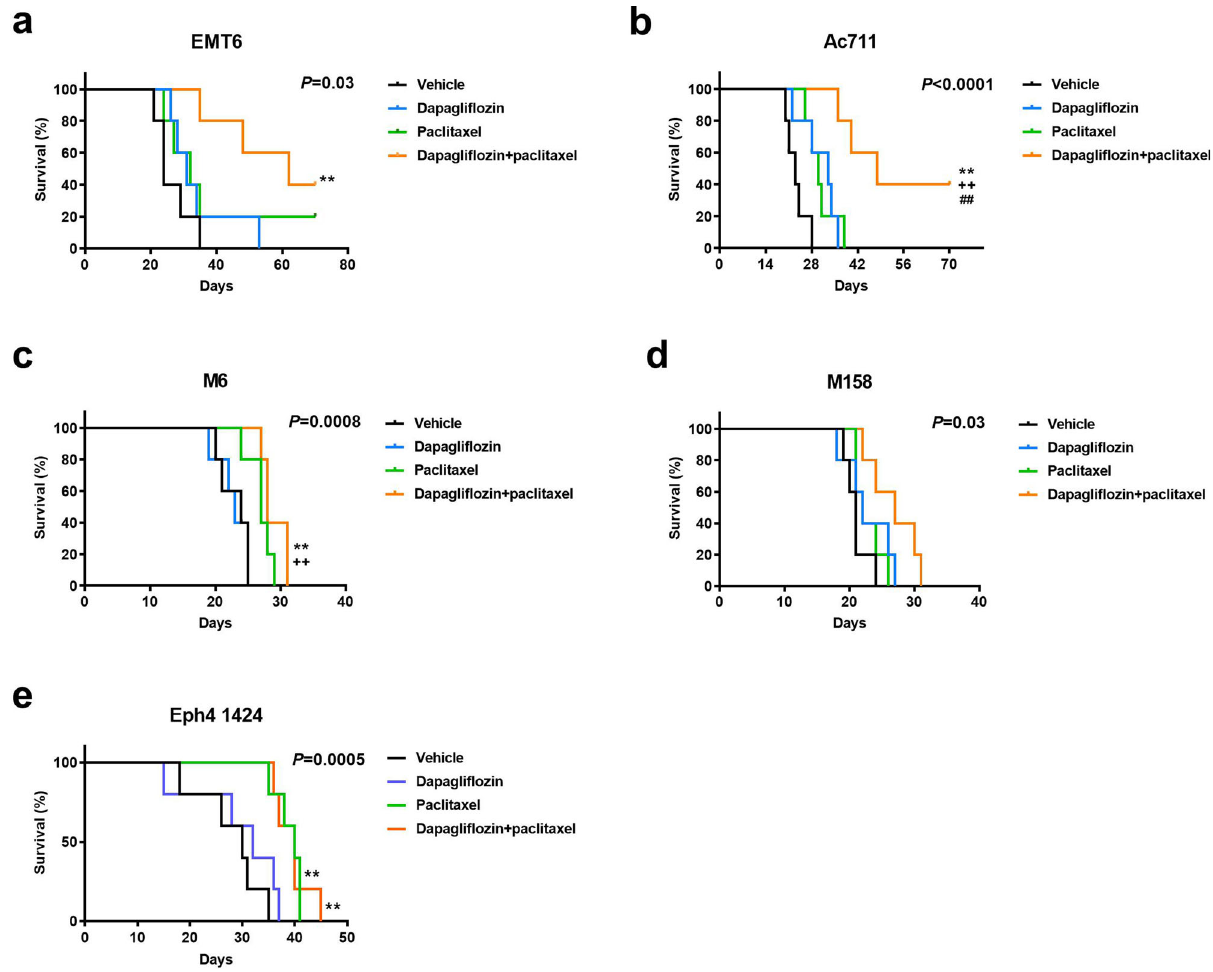
Fig. 6 Tumor drivers may predict the response to dapagli fl ozin as an adjunct to paclitaxel. a – e Survival in EMT6, Ac711, M6, M158, and Eph 1424 tumor- bearing mice, respectively. Mice were examined daily by an investigator who was blinded as to group allocation. ** P < 0.01 vs. vehicle, ++ P < 0.01 vs. dapagli fl ozin, ## P < 0.01 vs. paclitaxel by the Mantel-Cox log-rank test, adjusted for multiple comparisons. The P values in the upper right corner of each survival curve refer to the overall curve comparison using the Mantel-Cox log-rank test. Groups of n = 5 were studied.